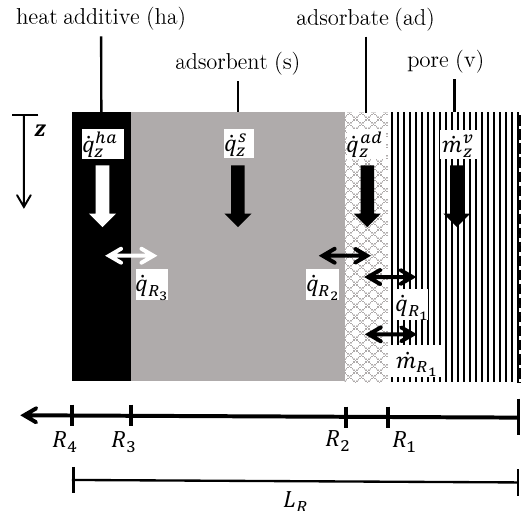
Figure A1. Sketch of linear material model with macropore, adsorbate, adsorbent and heat additive. Mass and heat transfer fluxes are indicated with